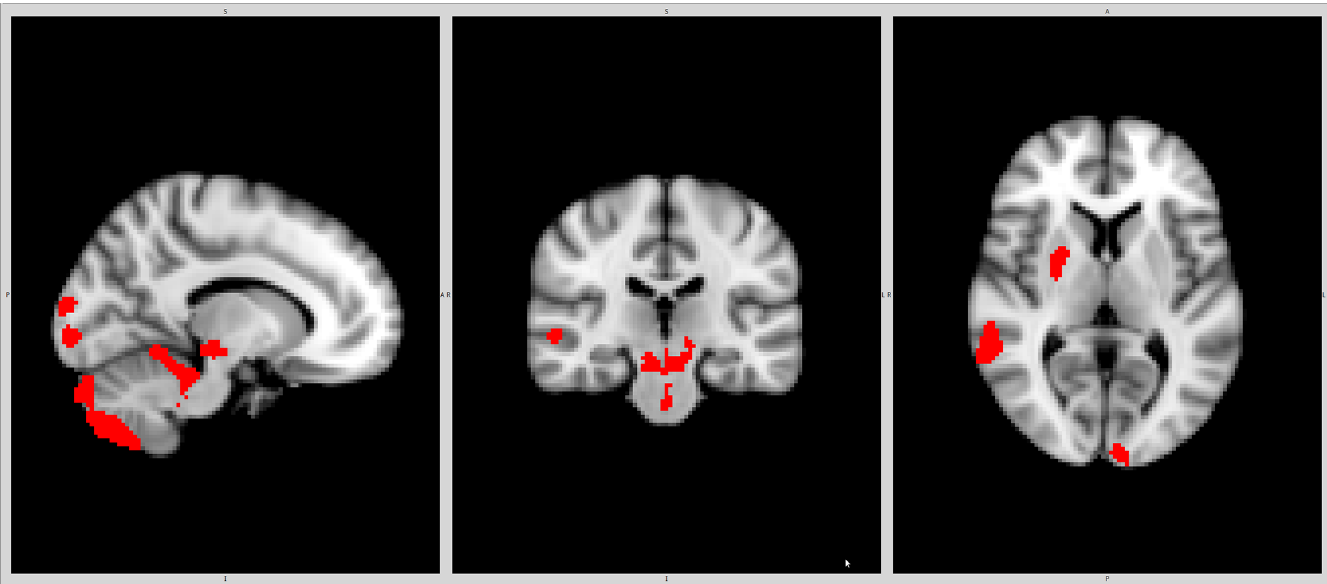
Fig 2. Regional brain volumes increased in clinically isolated syndrome compared to